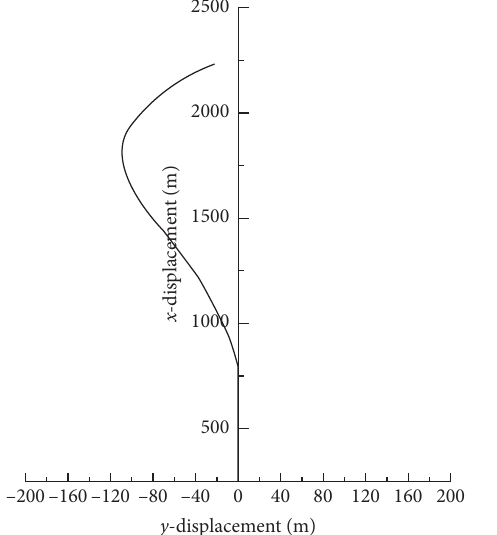
Figure 20: Trajectory for a rudder angle of 10 ° and a ship speed of 32km/h.